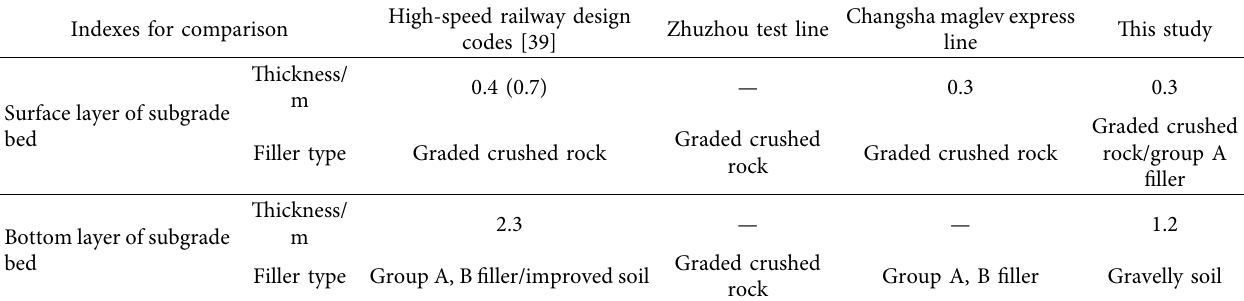
Table 8: Comparison of technical standards for an MLS Maglev structure.